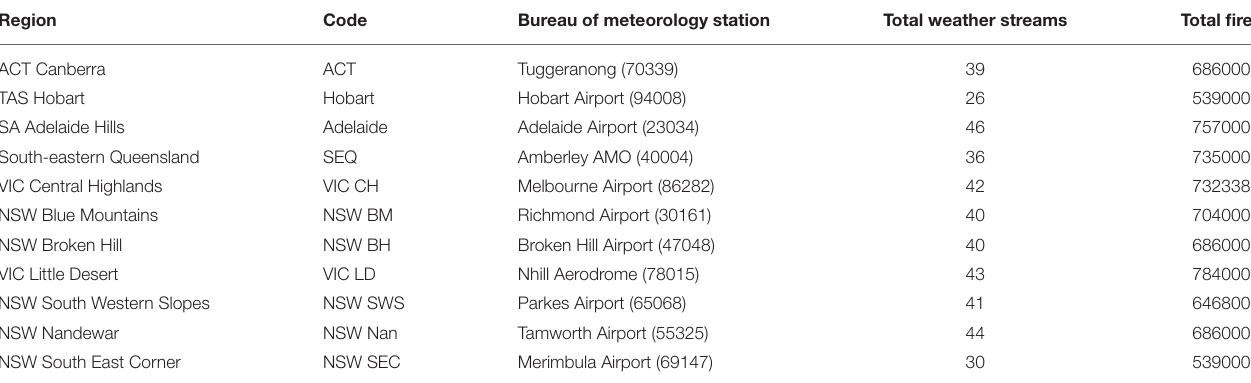
TABLE 1 | Weather and ignition data summary for each case study landscape. Region